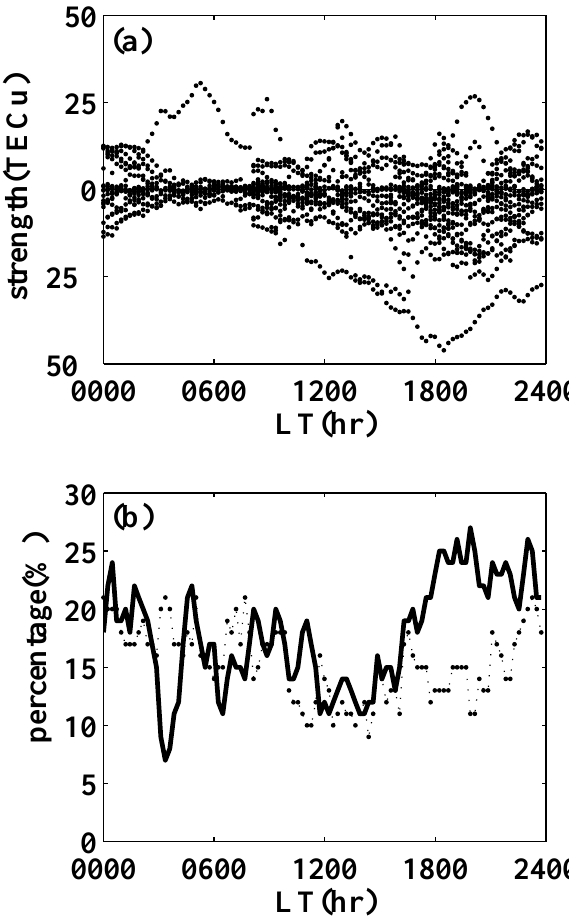
Fig. 6. The strengths and cumulative percentages of the V T EC anomalies appear 1–5 days before the 20M > = 6.0 earthquakes. (a) The upper and lower anomalies strengths. (b) The occurrence per- centages of the upper (dotted line) and lower (solid line)